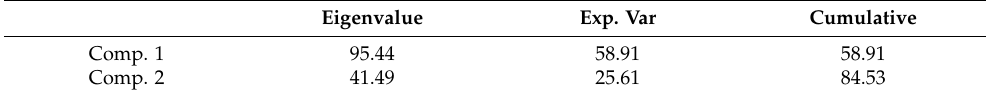
Table 5. Explained variance.